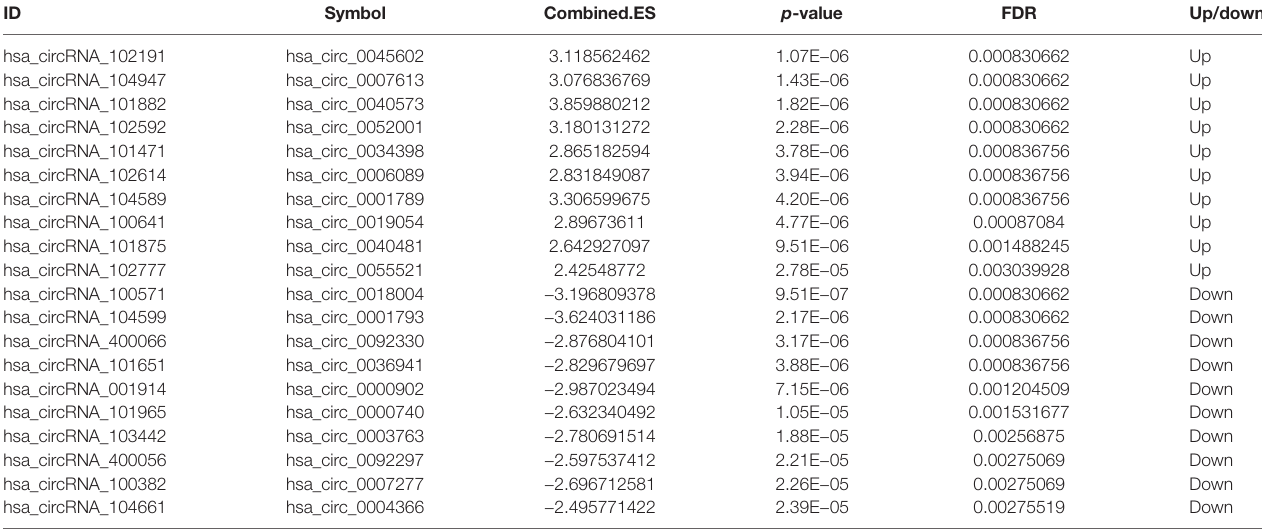
TABLE 2 | The top 10 upregulated and downregulated circRNAs in